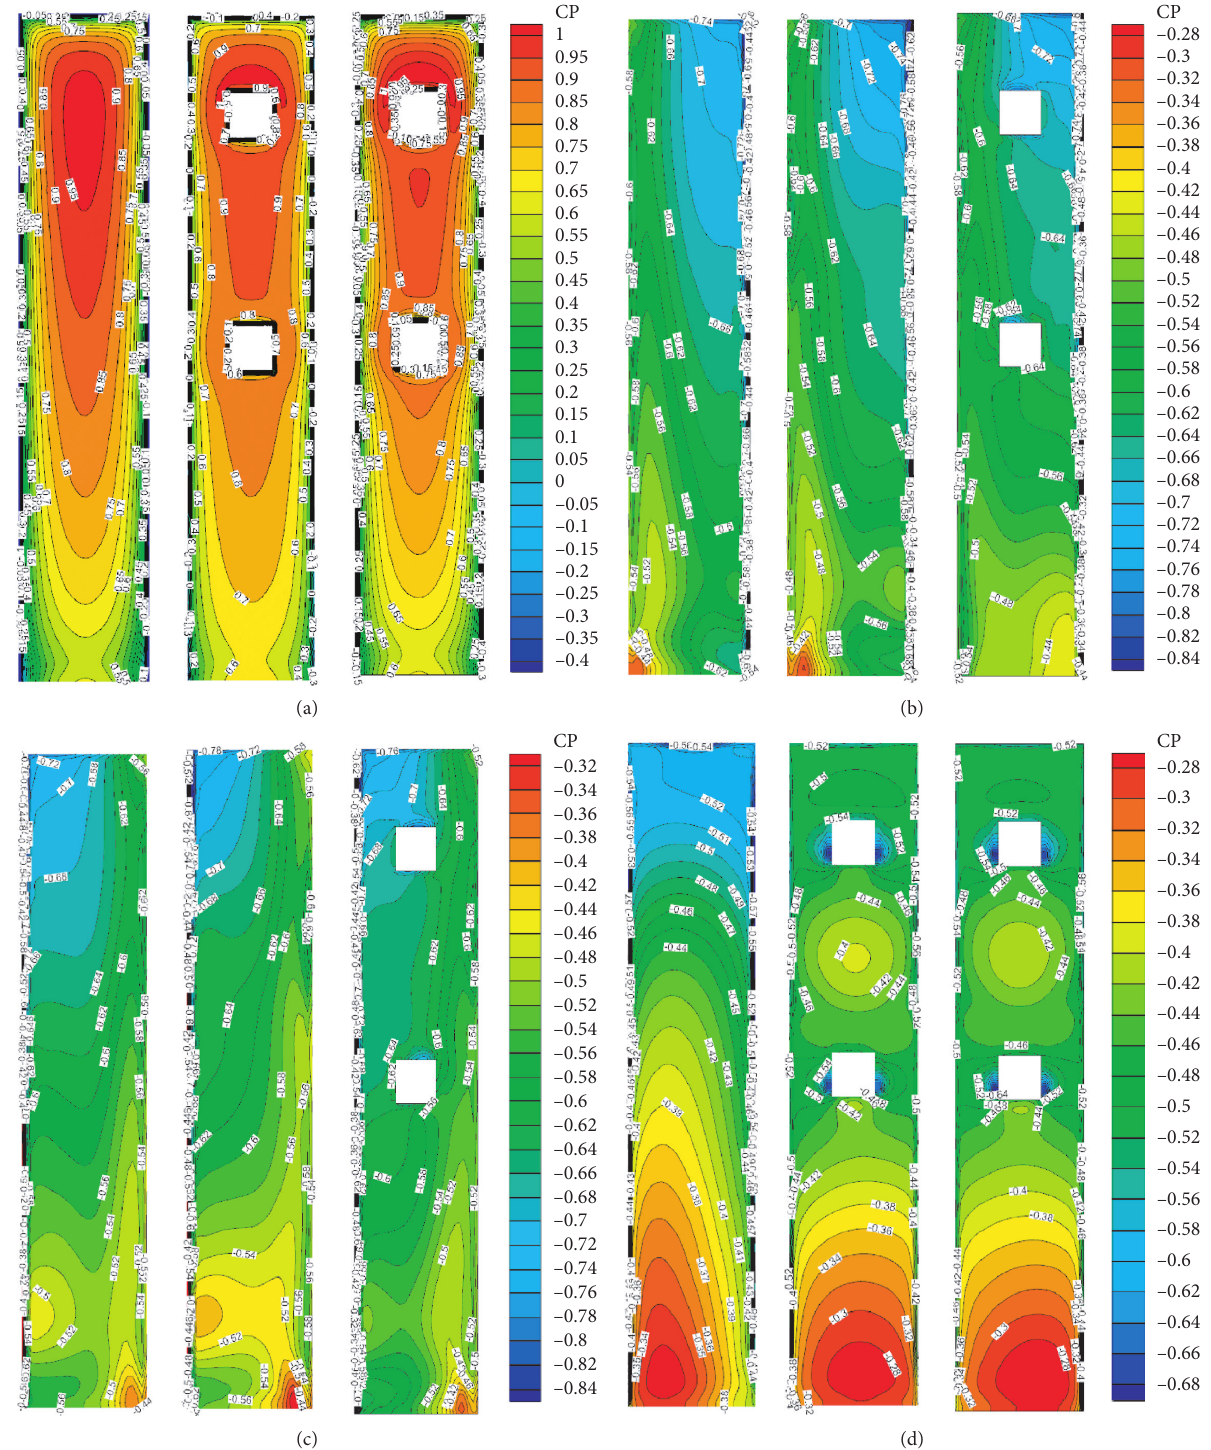
Figure 4: Mean wind pressure coefficients under wind direction of 0 ° . (a) Windward faces (from left to right, L-1, L-2, and L-3, the same below). (b) Left-side faces. (c) Right-side faces. (d) Leeward